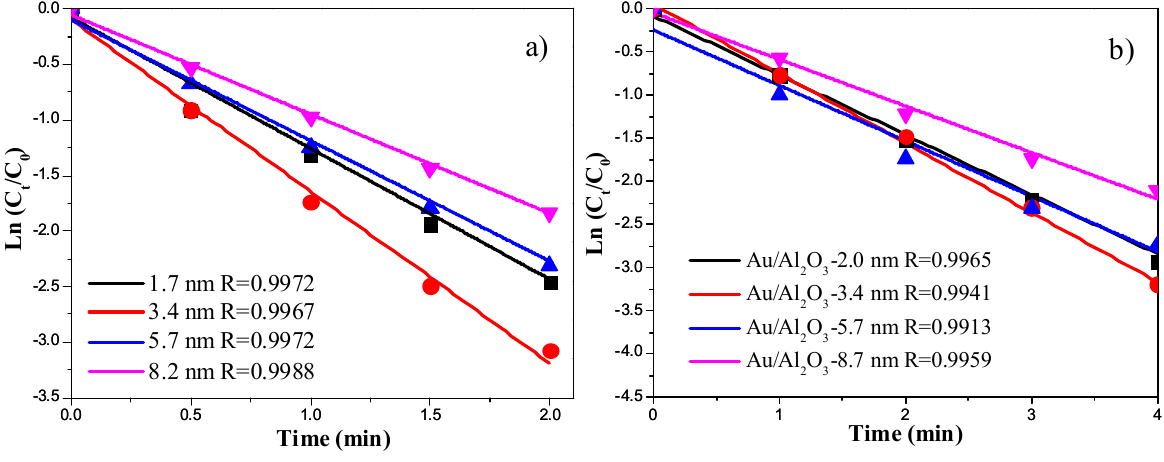
/C ) versus reaction time for Au NPs with different sizes; t 0 /C ) versus reaction time for Au/Al t 0